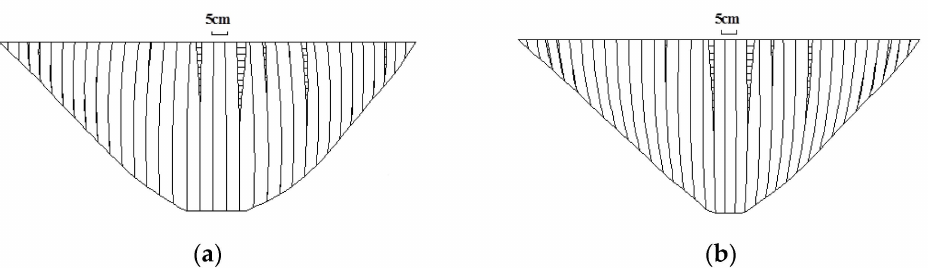
Figure 9. Envelopes of the contraction joint opening using the old standard (cm). ( a ) Upstream surface and ( b ) downstream